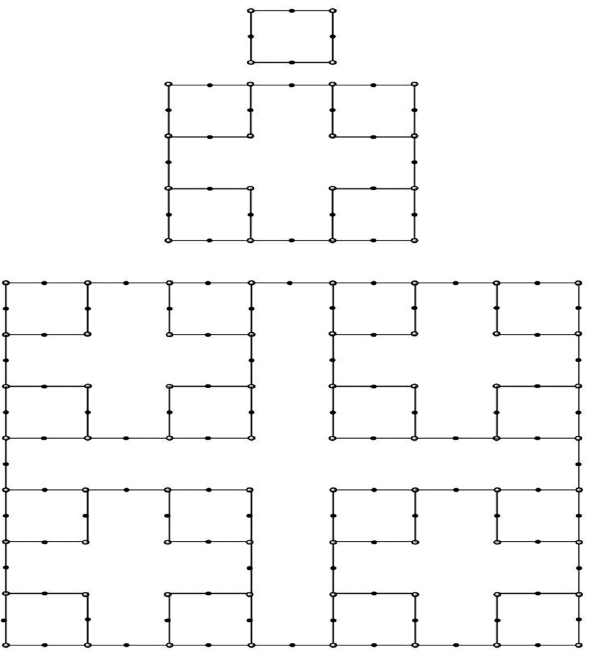
Figure 3: The generalized Sierpiński graphs for the SD ( S( 1,C SD ( S (2, C )), and SD ( S (3, C 4